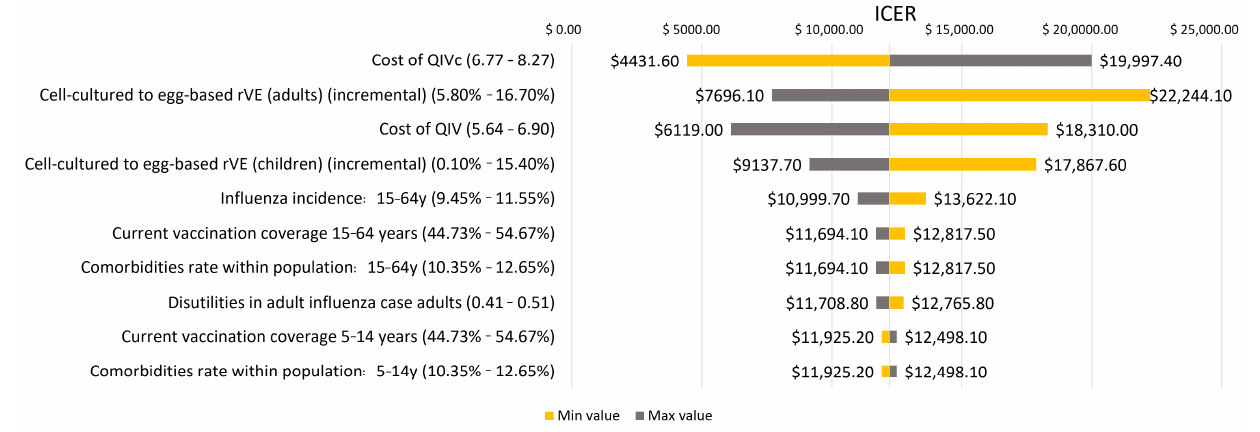
Figure 4. When assessing the results under WHO willingness-to-pay threshold recommendations and using the payer’s perspective, QIVc had a 39.0% chance of being highly cost-effective and 65.1% of being cost-effective when compared to QIVe vaccination [41]. QIVc: Quadrivalent Influenza vaccine—cell-based; QIVe: Quadrivalent Influenza Vaccine—based; rVE: relative Vaccine Effectiveness; y: years; ICER: Incremental Cost-Effectiveness Ratio